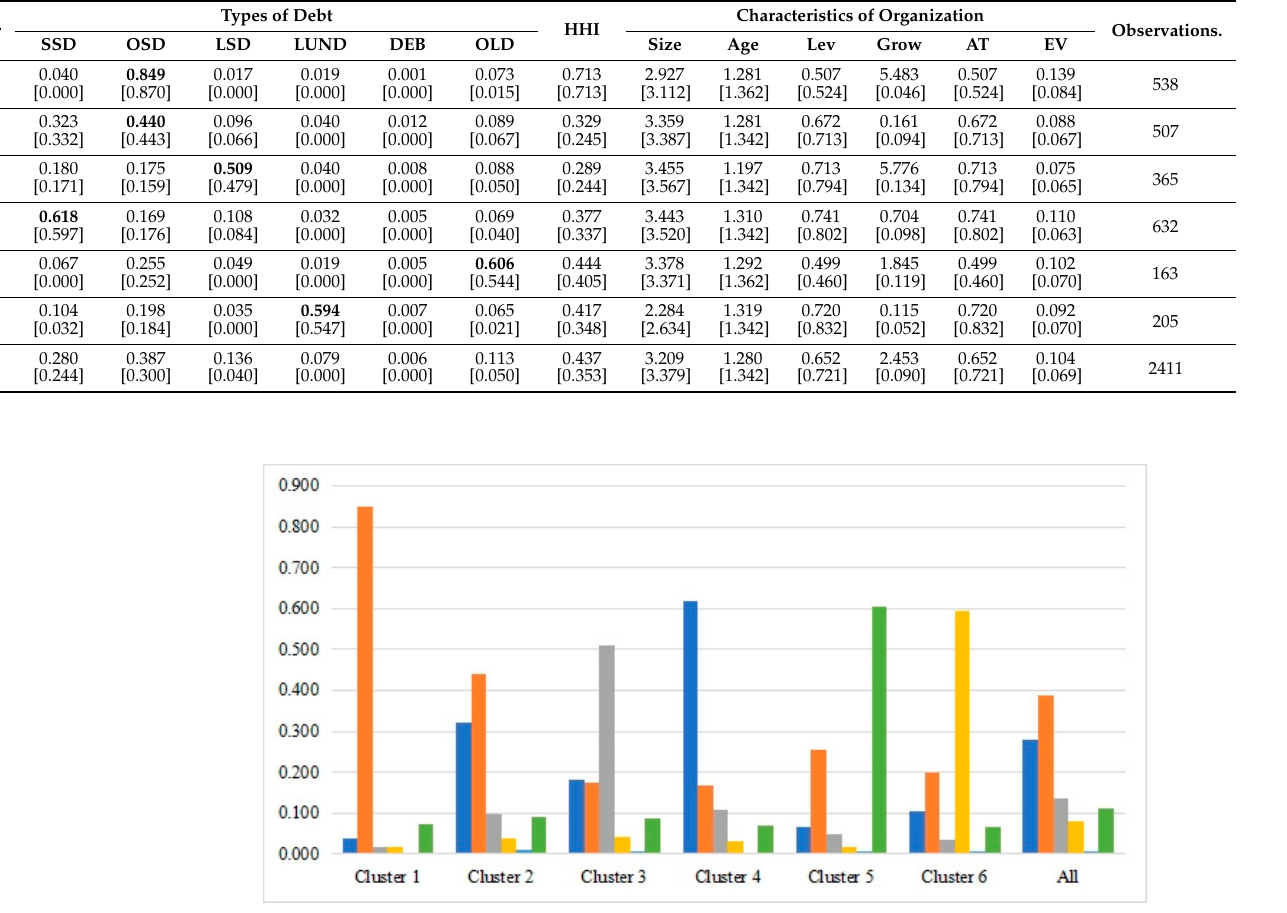
Figure 1. The distribution of debt types within a cluster. Table 4. Debt specialization cluster analysis.